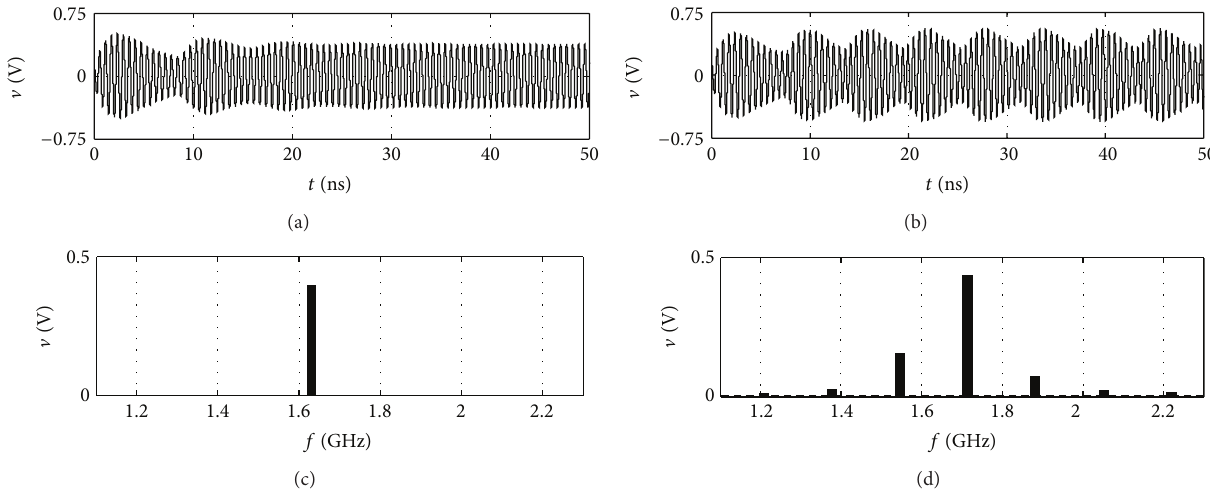
/3 = 0.6 and 𝑄Δ/𝜔 = 0.75 . (a) Waveform obtained with initial conditions: 0 in (0) = 0.1 𝑉 and 𝑖 (0) = 0 mA. (c) Spectrum of the 𝐶 𝐿